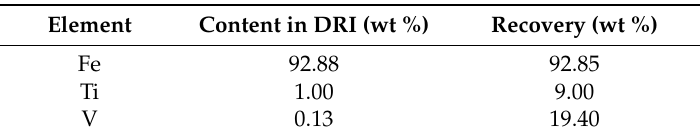
Table 5. Production index of DRI.